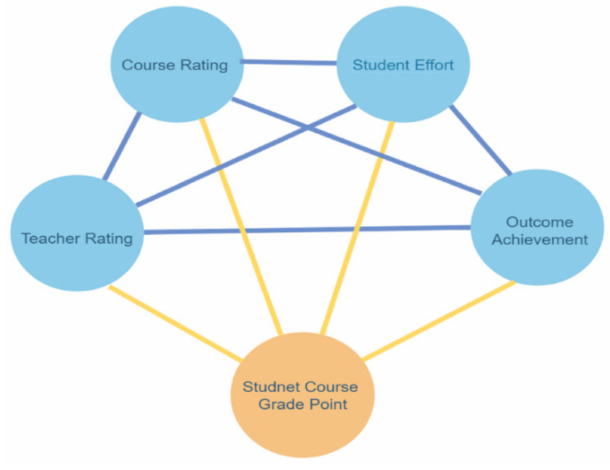
Figure 1. The relationship between the four SFQ categories and the student course grade to be analyzed in this study.